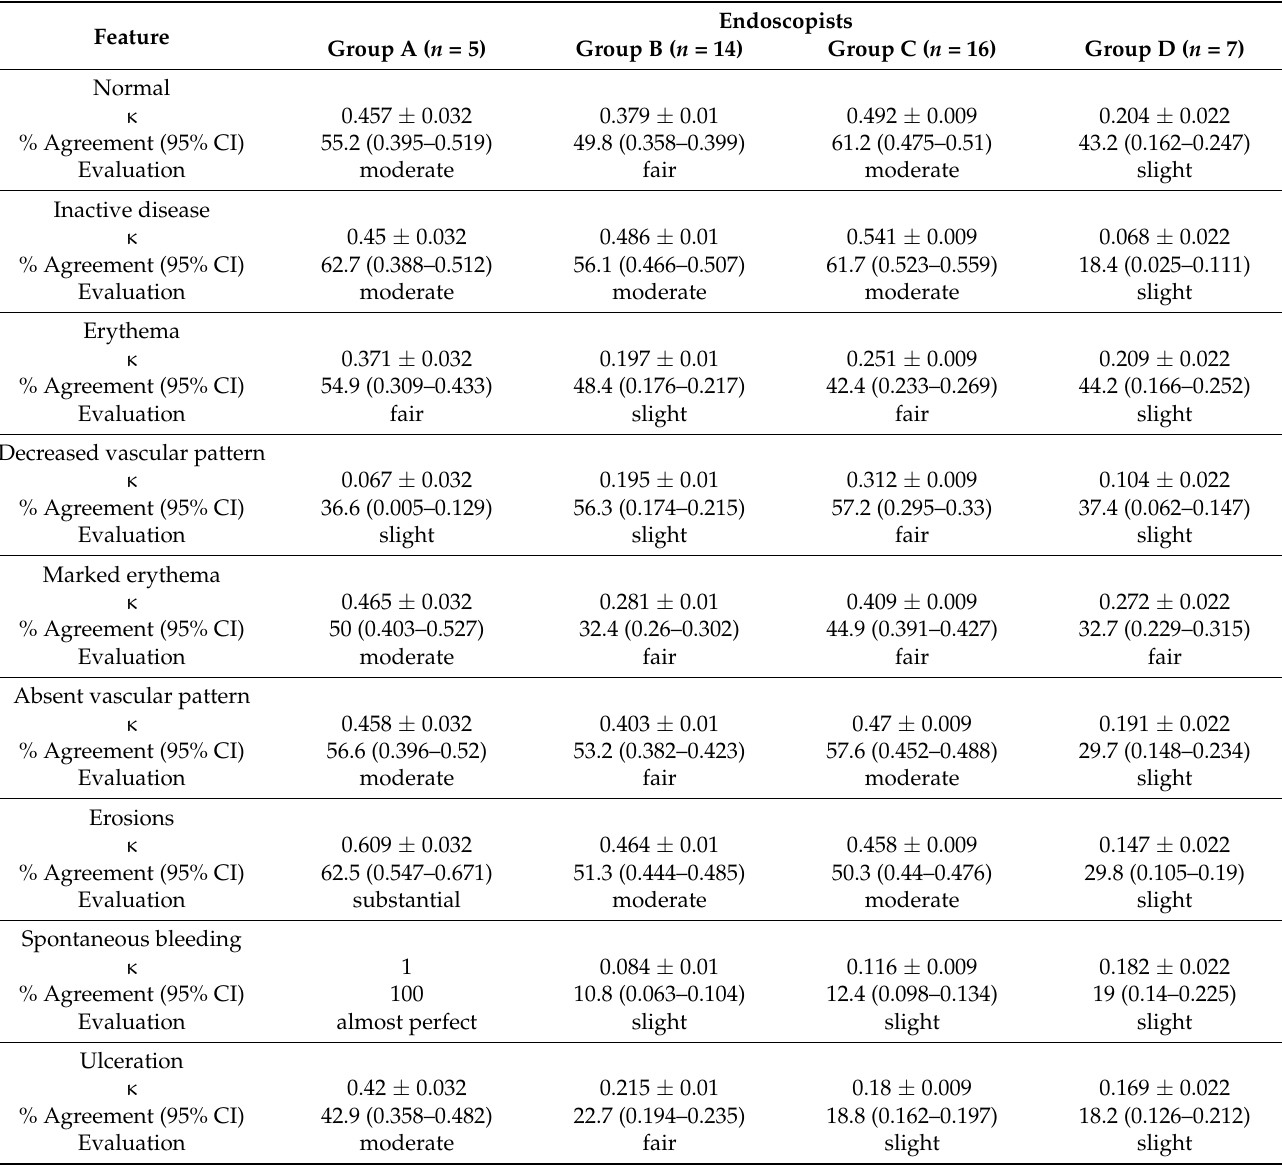
Table 2. Interobserver reliability of MES parameters for observer